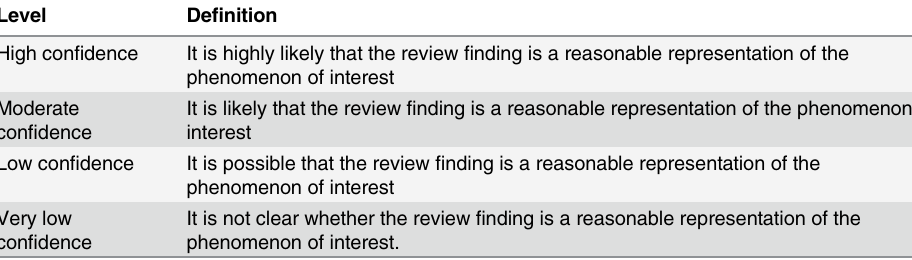
Table 3. The CERQual approach — Definitions of levels of confidence in a review